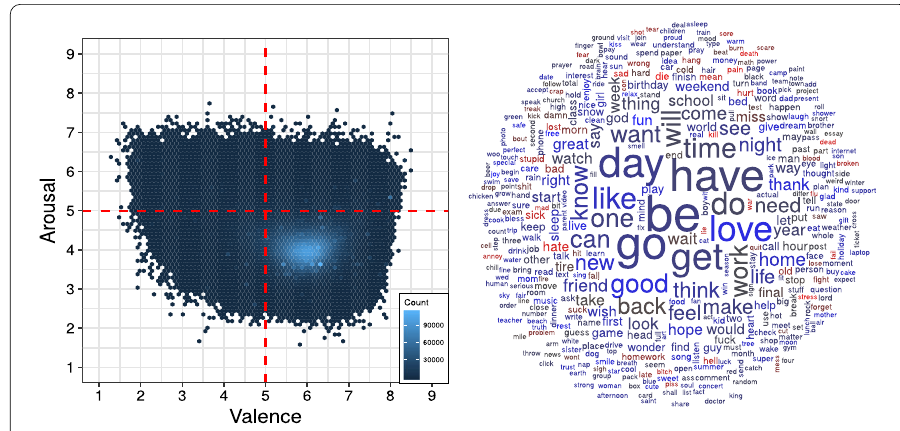
Figure 1 2d-histogram of user baselines and word cloud. The left panel shows the 2d-histogram of user baselines of valence and arousal (mean values). Red dashed lines highlight the midpoint of the 1–9 scales of valence and arousal. Individual baselines are concentrated below the midpoint of the arousal scale and above the midpoint of the valence scale. The right panel shows the word cloud of words in the WKB lexicon with a size corresponding to their frequency and a color corresponding to their valence value, from negative in red to positive in blue. Words with more than 5000 occurrences in the dataset are